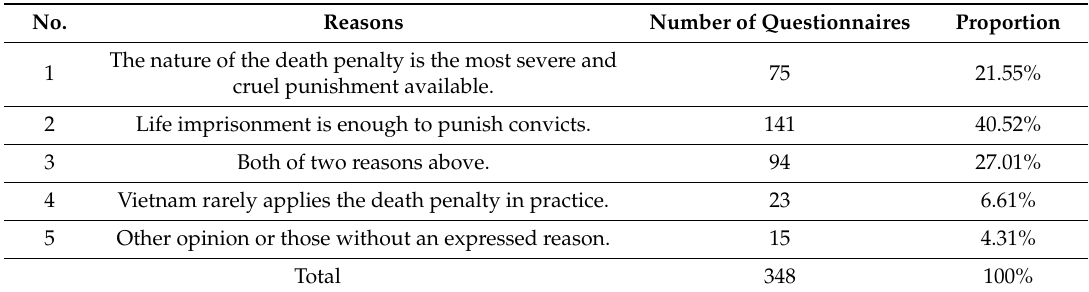
Table 7. Reasons for opposing the death